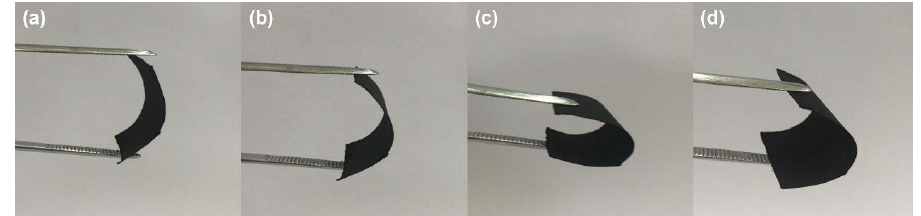
Figure 3. The flexible display digital photos of the PPy–NT/paper composite film.